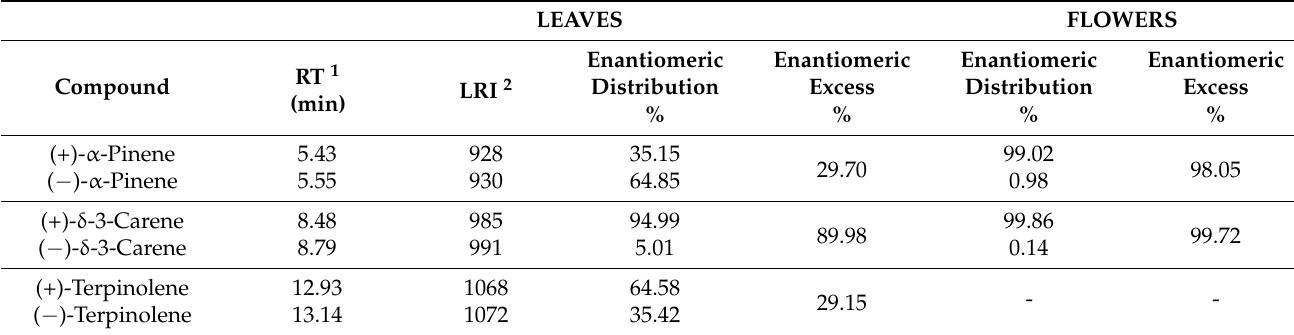
Table 2. Enantiomeric composition of L. paniculata essential oil. LEAVES